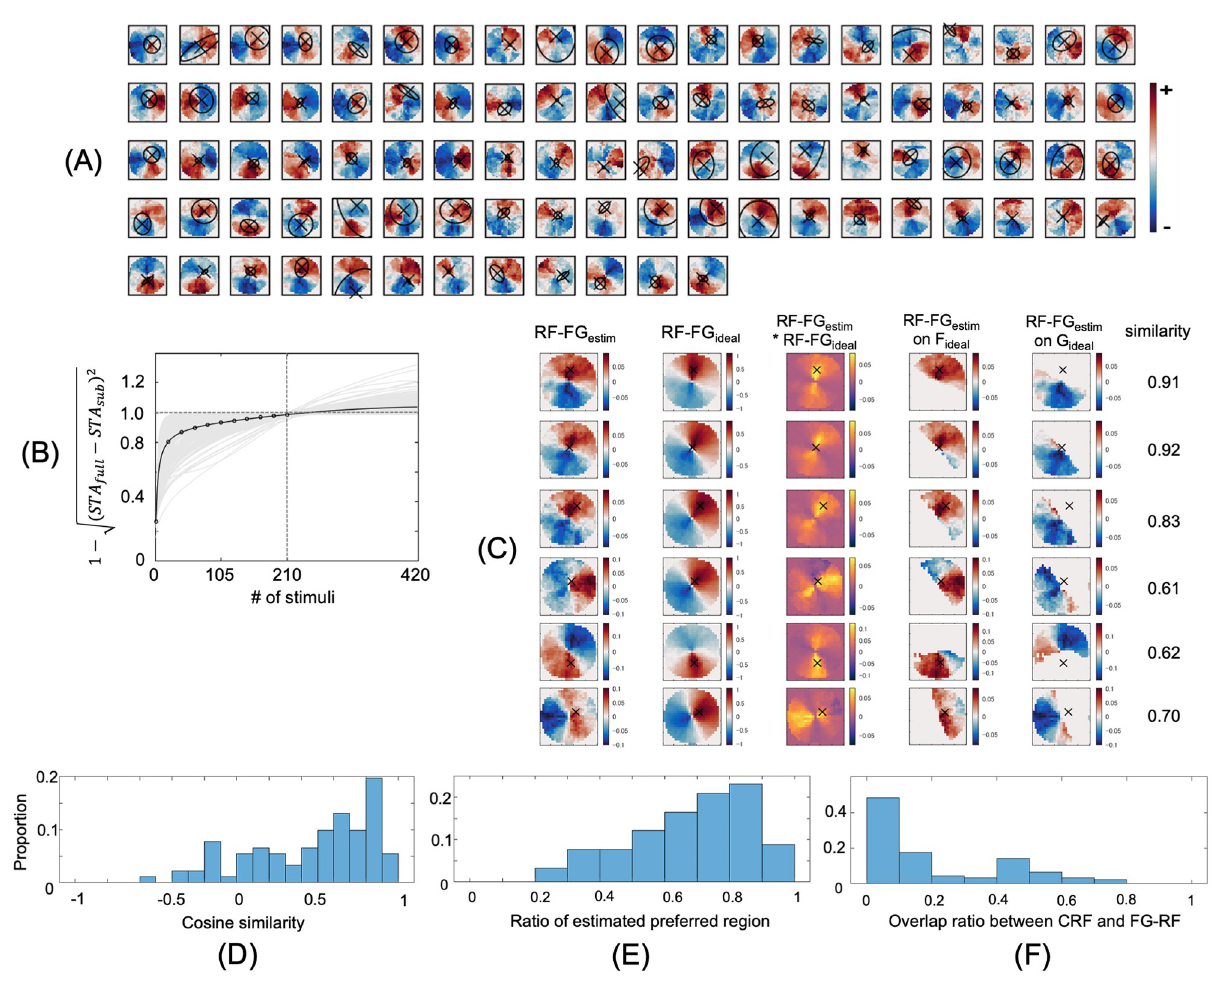
Fig 2. Estimated RF-FG STA s computed from the filled stimuli. (A) Estimated RF-FG STA s of the neurons that showed the significance in magnitude and a high convergence ratio ( > 0.9). The crosses and ellipsoids indicate the center and extent (1SD) of the CRF. The reddish and blueish colors indicate the regions that respond to figure (+) and ground (–), respectively, with the deeper colors representing the greater magnitudes. The magnitudes were normalized by the maximum. (B) Convergence of RF-FG STA magnitude. The light and dark lines indicate the convergence of individual neurons and their mean, respectively, which were fitted by Eq (2). The ordinate is normalized so that the unity indicates the magnitude of RF-FG STA with 210 stimuli. (C) Comparison between the estimated and ideal RF-FGs for six example neurons with preference to figure. The two left-most columns show the estimated and ideal RF-FG STA s, and the third column shows the product of the two. The fourth and fifth columns show the trimmed RF-FG STA s that were located on the figure and ground subregions of the ideal RF-FG STA , respectively. The magnitudes were normalized for each neuron, and the colors were normalized for each panel. The extent of panels was identical to that of stimulus patches. The right-most column indicates the cosine similarity between the estimated and ideal RF-FG STA s. The cosine similarity was given by the Euclidean dot product with two RF-FGs treated as vectors. (D) Distribution of the cosine similarity. (E) Distribution of the ratios between the extent of the estimated preferred-region and that of the ideal preferred-region. (F) Distribution of the overlap ratios between the extents of the CRFs and preferred